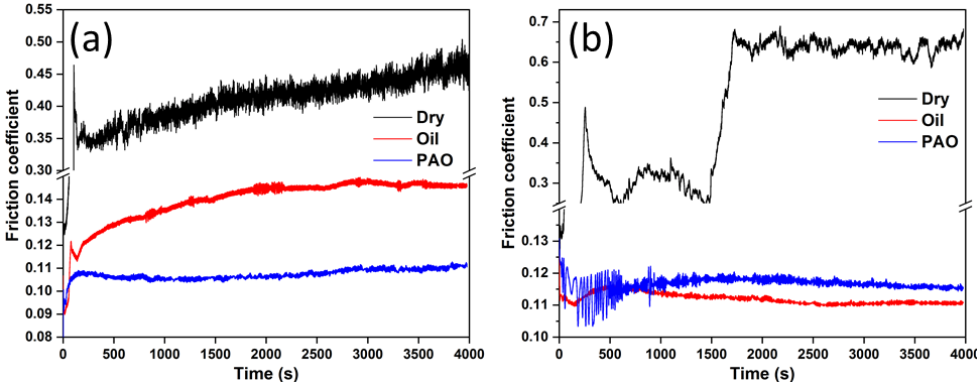
Figure 7. Variation of the friction curves with sliding time for the Al – Si substrate ( a ) and the Ni – Co – P/Si 3 N 4 composite coated specimen, under dry conditions and lubrication with PAO and engine oil ( b ).